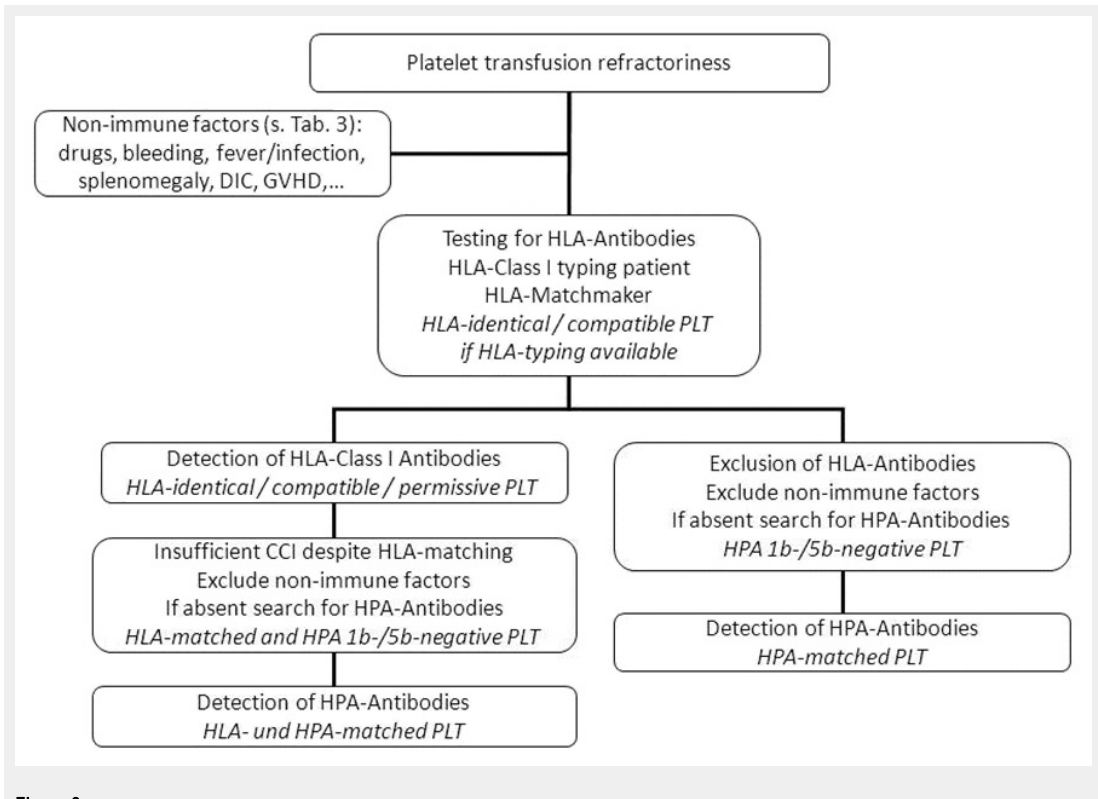
Figure 3 Proposed algorithm for the management of patients with platelet transfusion refractoriness. DIC = disseminated intravascular coagulation; GVHD = graft-versus-host disease; HLA = human leucocyte antigen; HPA = human platelet antigen; PLT = platelet components